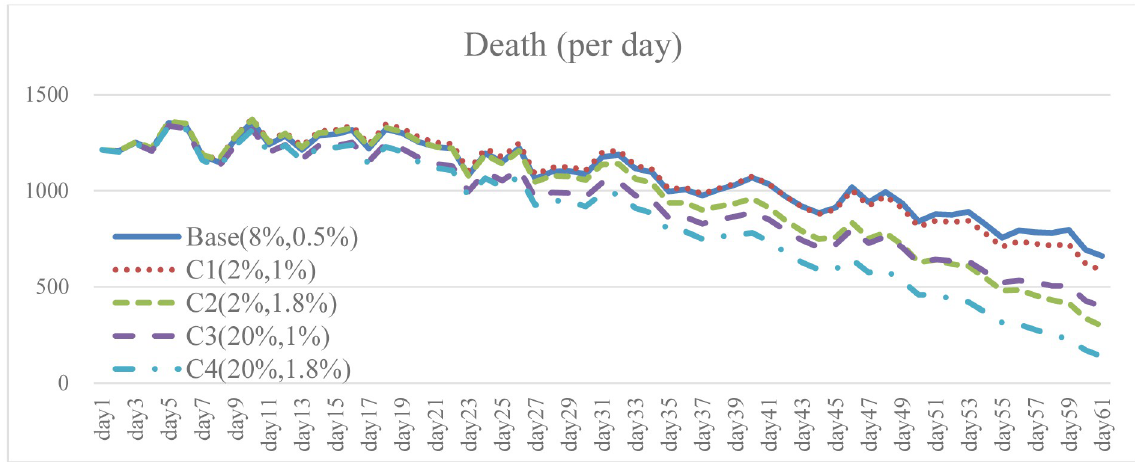
Fig 17. Daily death under different isolation percentage and vaccine